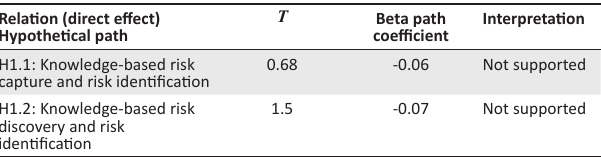
FIGURE 3: Bootstrapping the T -value for knowledge-based risk processes on risk identification without mediation of knowledge-based risk repository. TABLE 5: Test results for H1.1 and H1.2.